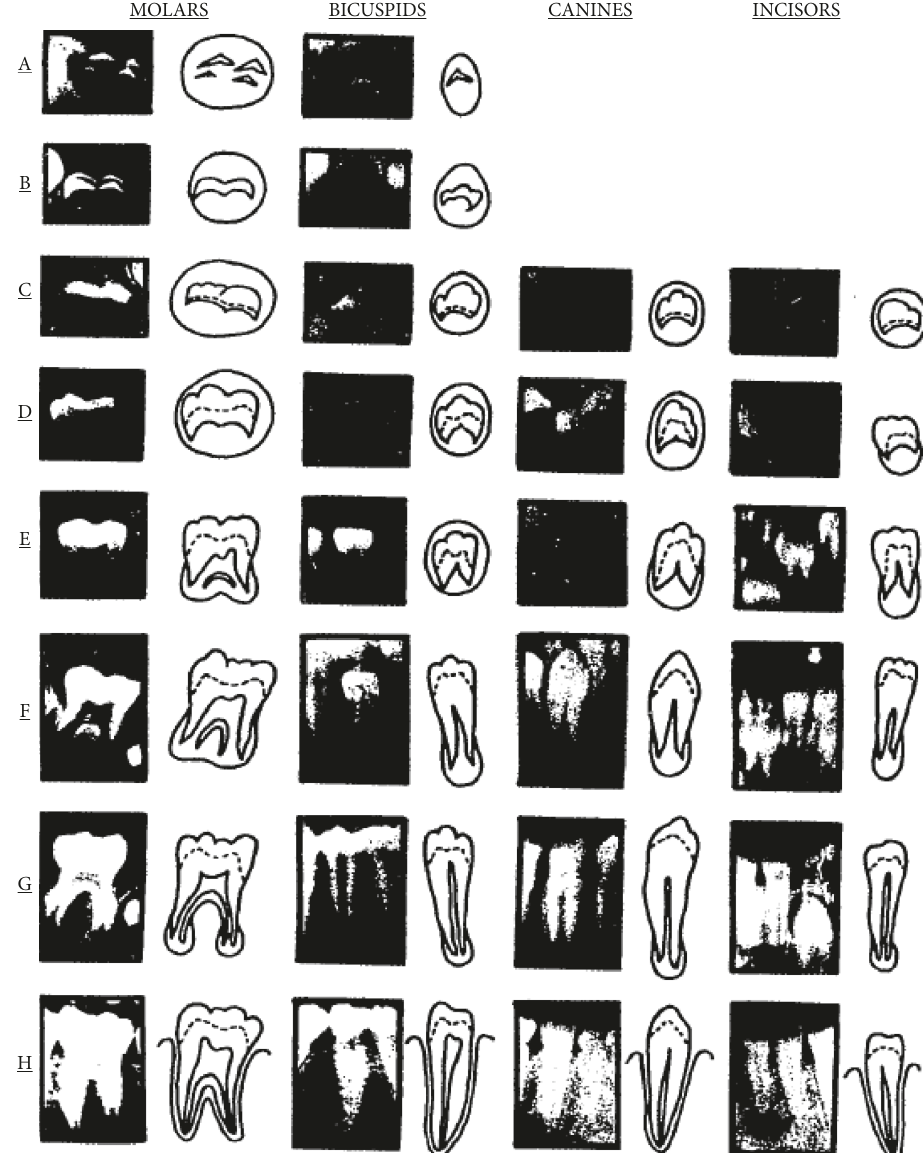
Figure 1: Developmental stages of permanent teeth according to Demirjian’s method